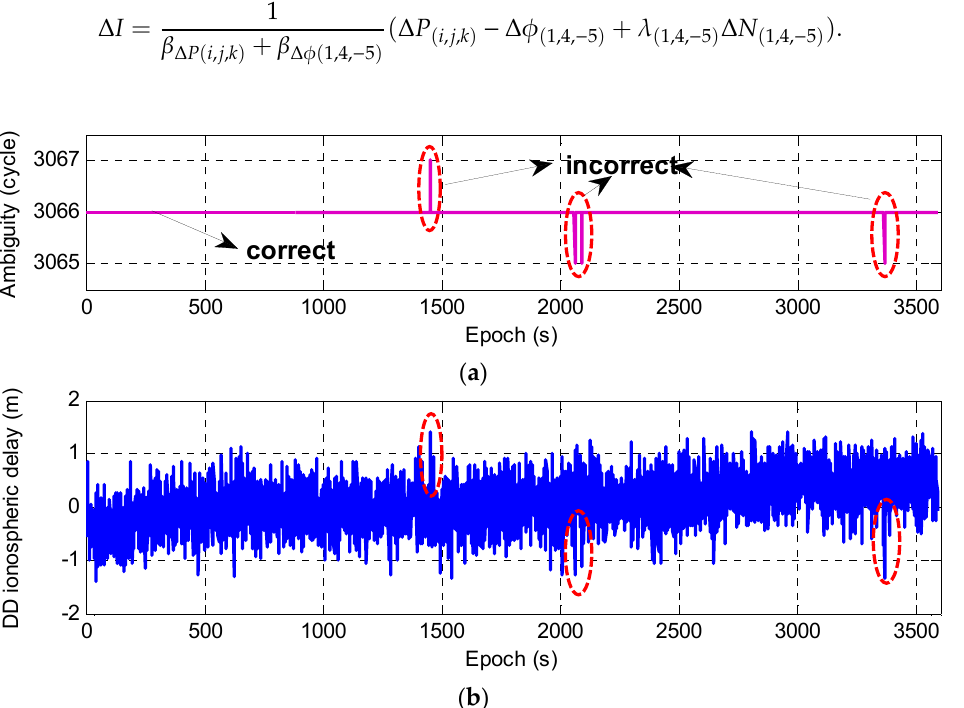
Figure 3. Performance of fixed ambiguity ( a ) and DD ionospheric delay ( b ) for satellite C05.